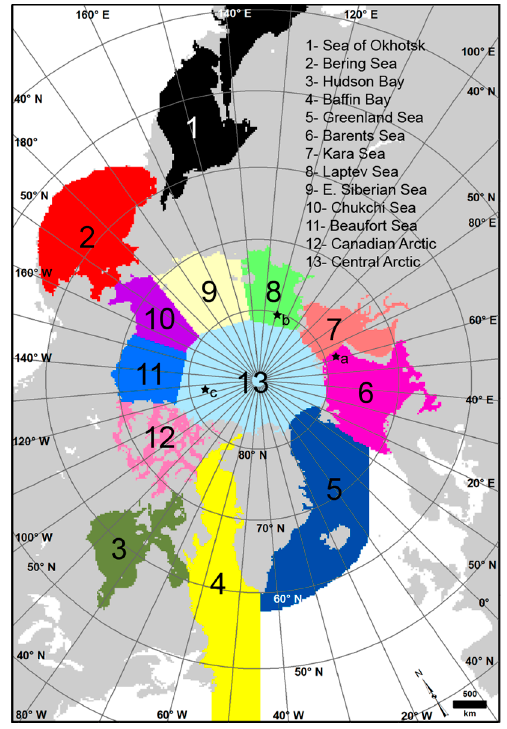
Figure 1. Regions of the Arctic. Stars indicate locations in the Barents Sea (a); Laptev Sea (b); and central Arctic (c) discussed in Section 3.1.